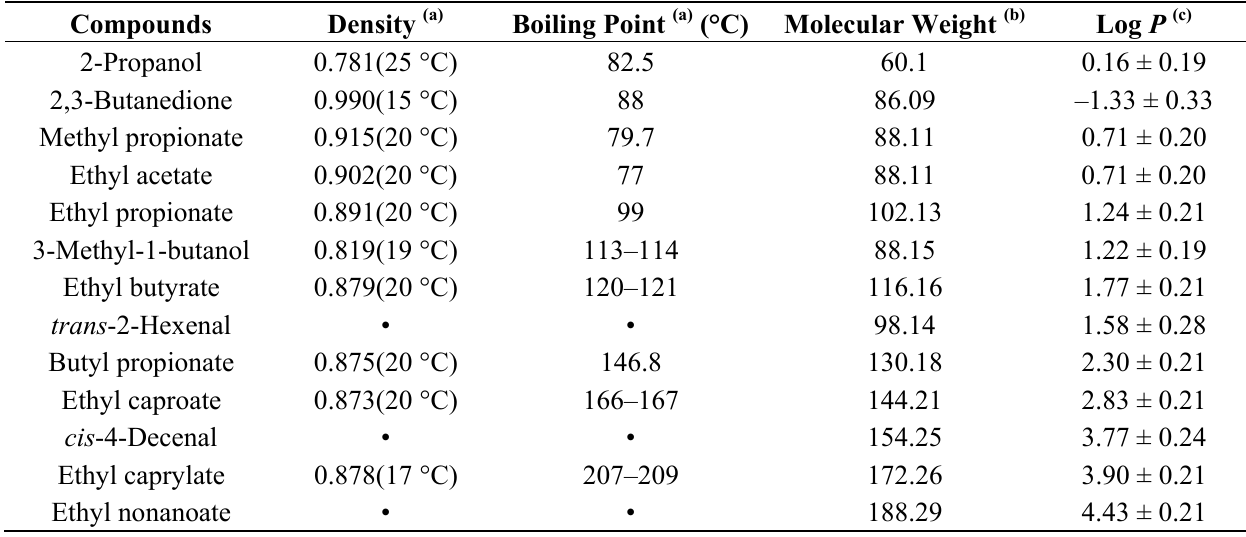
Table 1. Physicochemical properties of odor